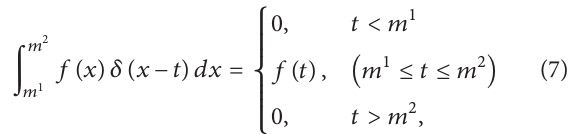
of bogie; 𝑘 11 , 𝑐 11 , 𝑘 12 , 𝑐 12 are the front and back suspension parameters of the bogie primary suspension system, respec- tively; 𝑘 𝑡1 , 𝑐 𝑡1 , 𝑘 𝑡2 , 𝑐 𝑡2 are the parameters for Hertzian contact occurring between the front and back wheels and the rail, respectively; 𝑘 2 , 𝑐 2 are the secondary suspension parameters; 𝑍 𝑍 𝑐𝑡1 and 𝑐𝑡1 are the displacements of the front and back ̇𝑍 ̇𝑍 wheels at the contact points, respectively; 𝑐𝑡 1 and 𝑐𝑡 2 are the displacement rates of the contact points for the front and back wheels, respectively. From (1)–(4), the general equation of the motion for the quarter vehicle is obtained as